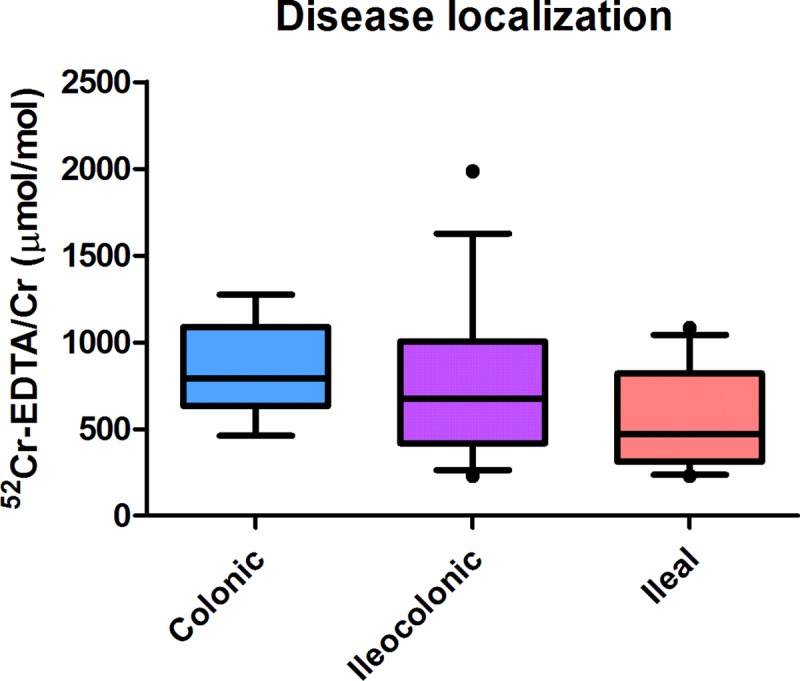
Urinary 24-h excretion of 52Cr-EDTA/creatinine for different subgroups of CD patients according to the Montreal classification of disease localization.No significant differences were observed between any groups (P > 0.05).